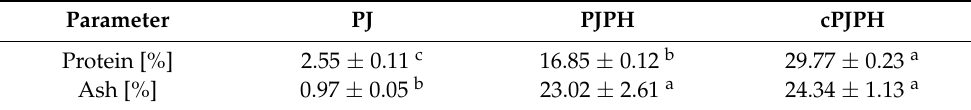
Table 1. Chemical composition of the analyzed products.